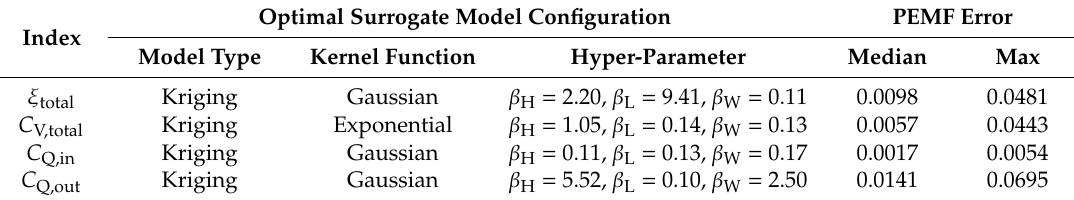
Figure 11. Surrogate model selection of hydraulic performance indices: ( a ) ξ ; ( b ) C V ; ( c ) C Q,in ; ( d ) C Q, out . Table 6. Optimal surrogate model configurations and their Predictive Estimation of Model Fidelity (PEMF) errors.